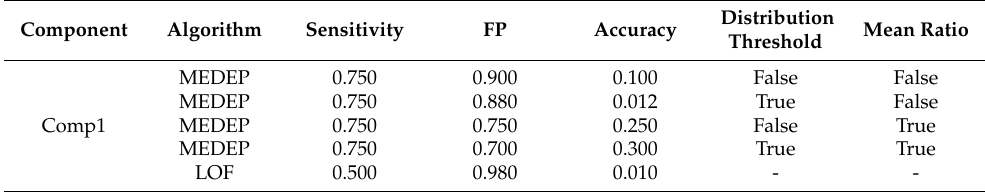
Table 5. MEDEP maintenance event detection results for one component of a single industrial welding